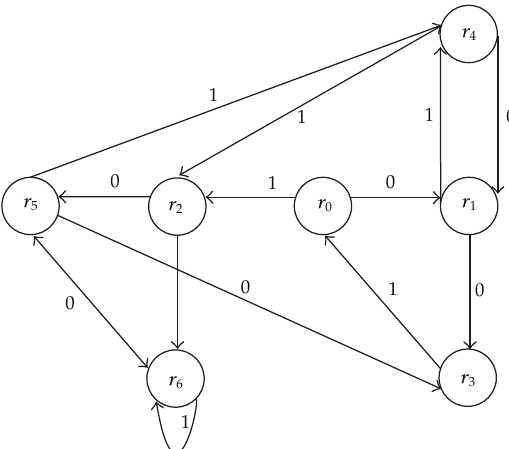
Figure 1: The corresponding graph G 14